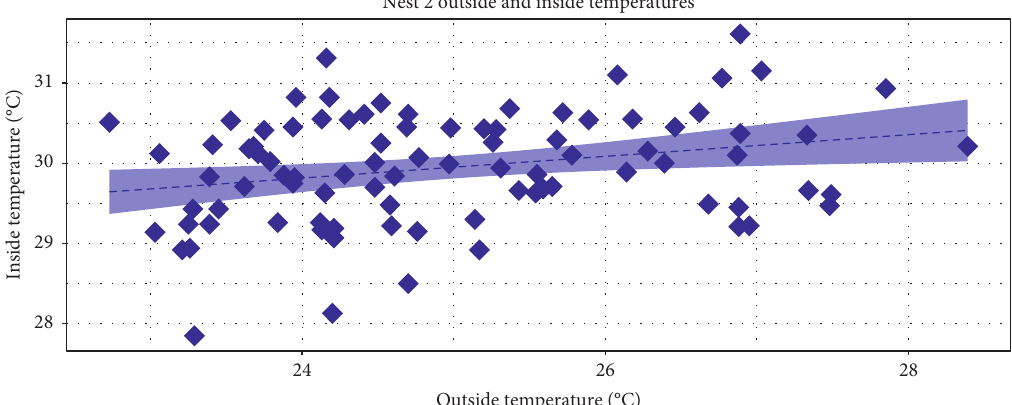
Figure 3: Correlation of nest 2 mean daily incubation temperature and mean daily ambient temperature.